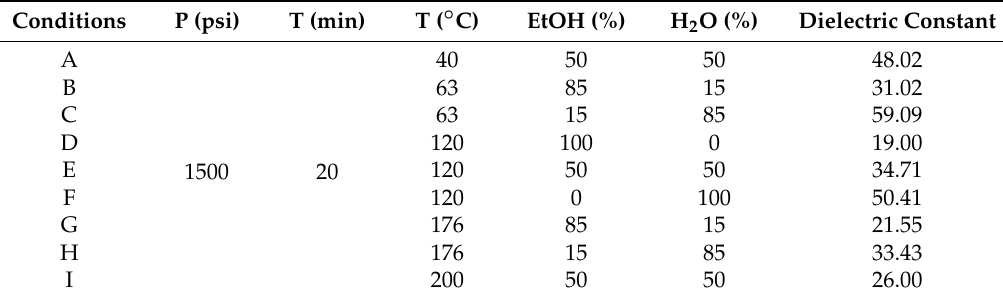
Table 3. Extraction parameters of